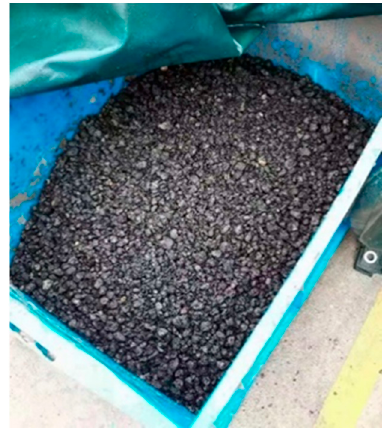
Figure 7. The nodules after crushing by the crusher.